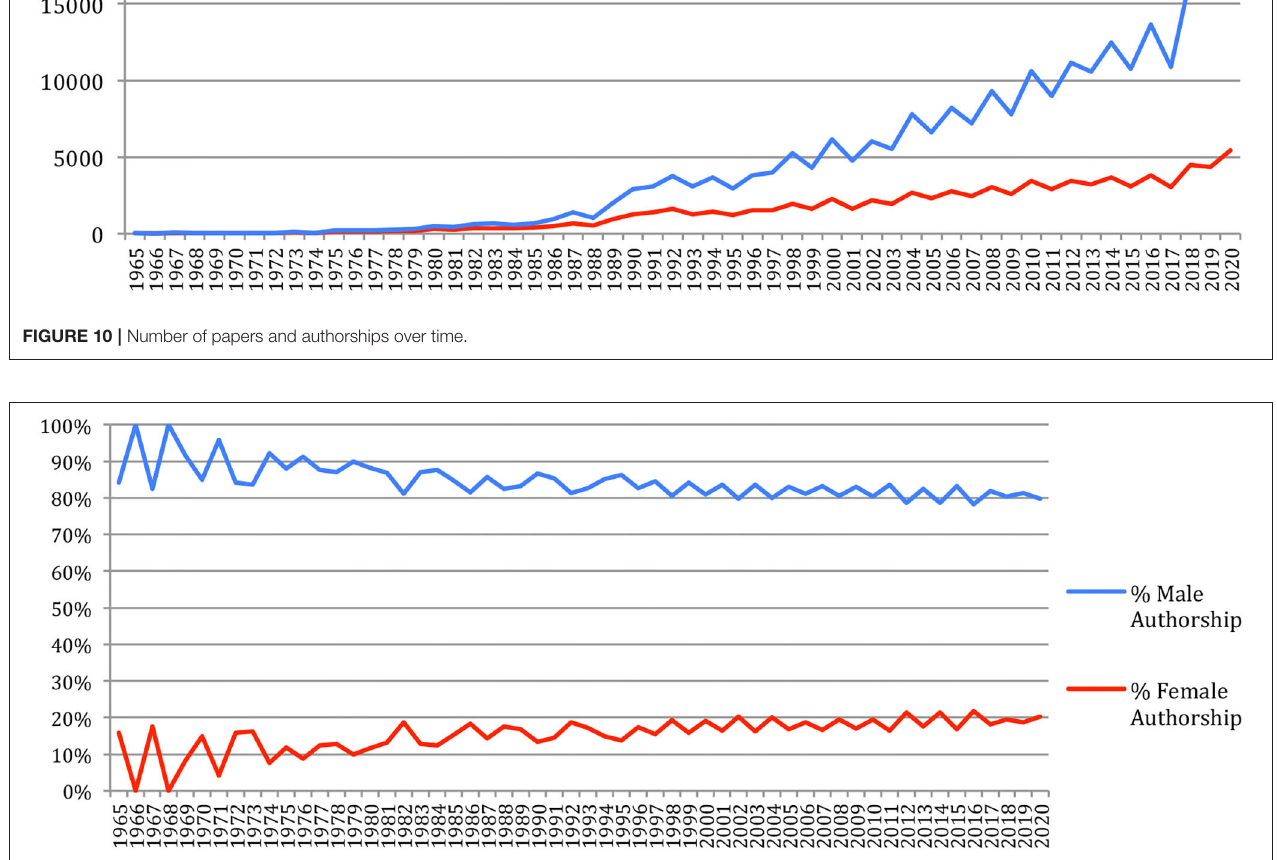
FIGURE 11 | Gender of the authors’ contributions over